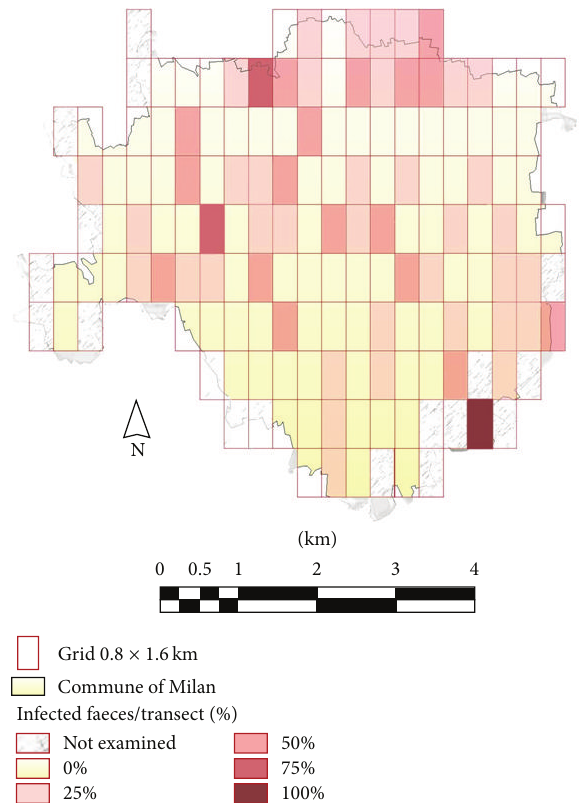
Figure 2: Proportion of dog faecal samples infected by parasites for each subarea of the metropolitan area of Milan (north-western